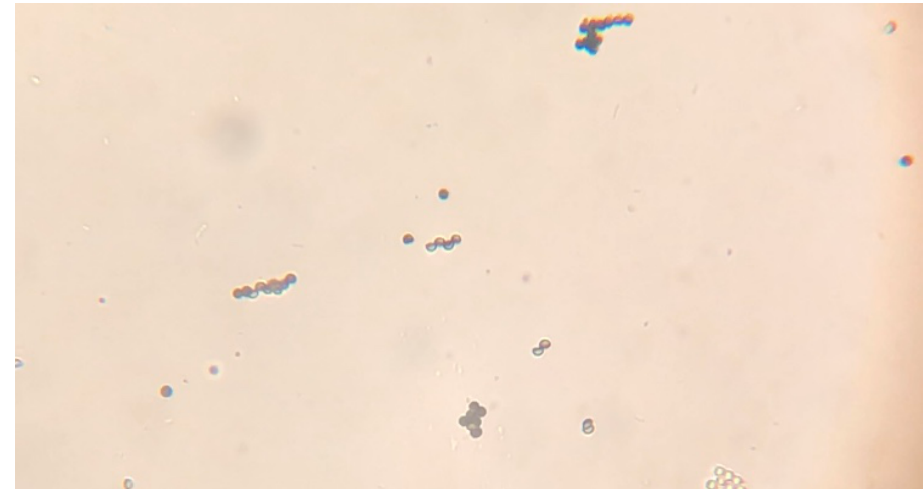
Figure A2. Microscope photograph of Ni-coated hemispherical Janus particles in water after a magnetic field was applied for a long time. (Referred in Section 3.3).